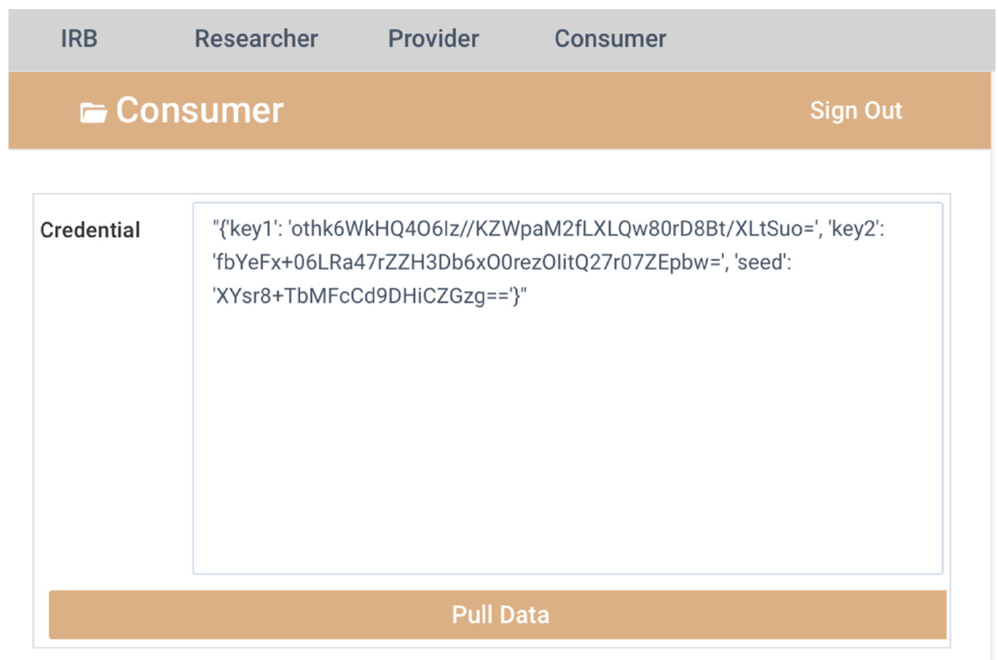
Figure 17. The credential which is presented to the CDM consumer as proof.